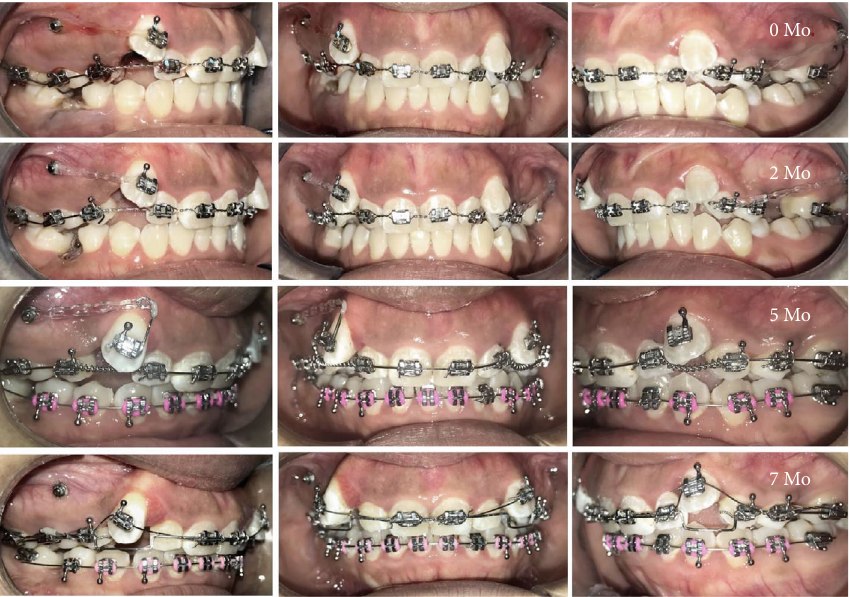
Figure 2: Usage of unmitigated forces causing distal crown tipping and buccalization of #13 root.